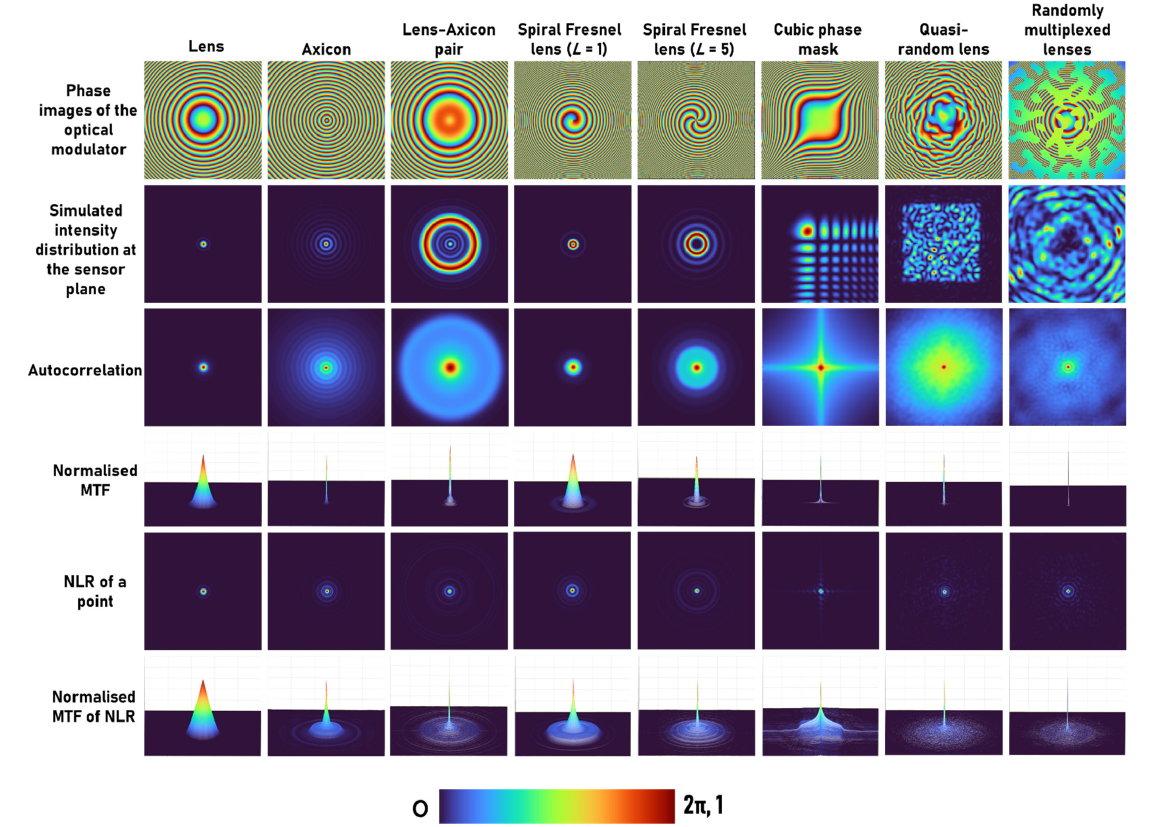
Figure 2. Comparison between different phase modulators according to functions and distributions that related to image reconstruction and resolution. that related to image reconstruction and The Fresnel diffraction patterns were simulated for all the above cases. Autocorrela-